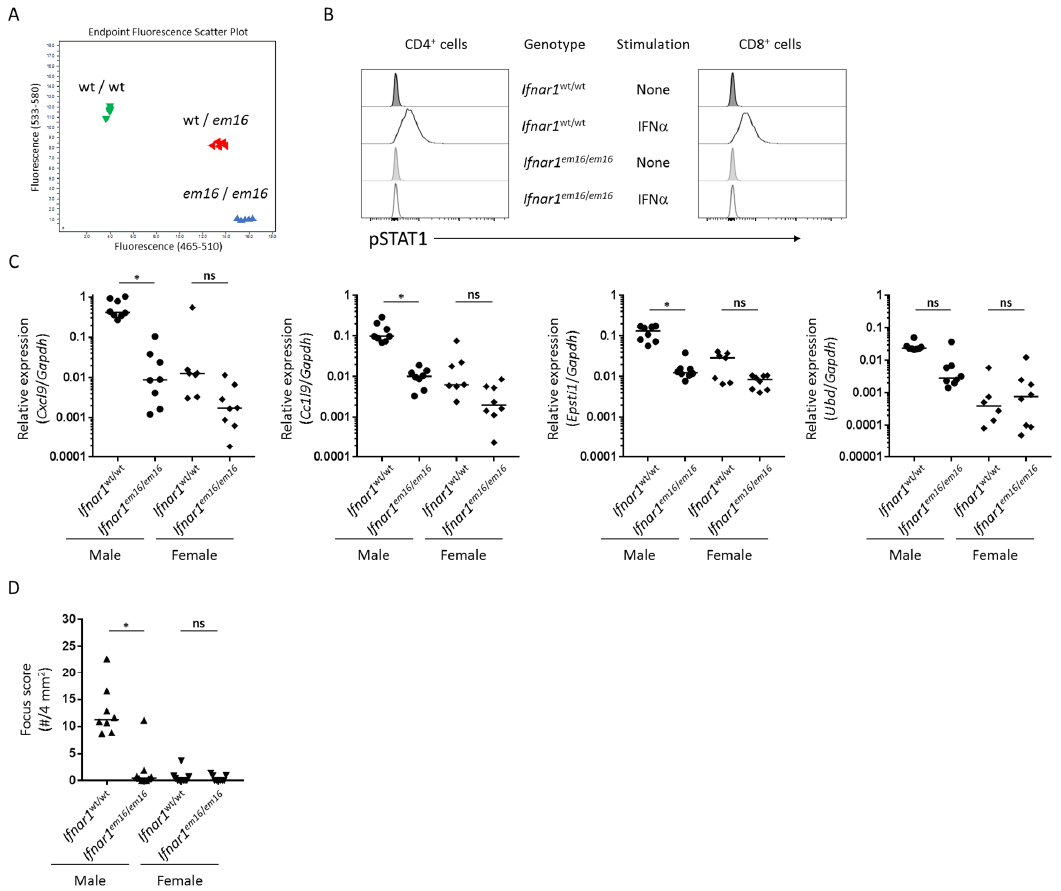
Figure 4. Type I IFN signaling is required for dacryoadenitis in male NOD mice. ( A ) Disruption of Ifnar1 in NOD mice was confirmed by genotyping with Taqman probe assay for the em16 mutant allele − 5 bp deletion. ( B ) Functional deficiency in IFNAR1 signaling was confirmed by flow cytometry. Whole blood from wild-type ( Ifnar1 wt/wt ) or Ifnar1 -deficient ( Ifnar1 em16 / em16 ) mice was stimulated with IFN α for 30 min then fixed and analyzed by flow cytometry for phosphorylation of STAT1 (pSTAT1). Histograms show pSTAT1 staining for CD4 + cells (left) or CD8 + cells (right). Cells not exposed to IFN stimulation were included as no stimulation controls. Similar levels of pSTAT1 staining was apparent from each group when stimulated with IFN γ as positive control (not shown). Data are representative of 2 mice per genotype. ( C ) Graphs depict gene expression of indicated genes normalized to that of Gapdh in lacrimal glands of 14–16 week old wild-type (Ifnar1 wt/wt ) or Ifnar1 -deficient ( Ifnar1 em16 / em16 ) male or female NOD mice as indicated on x-axis. Symbols represent individual mice, lines are medians. Relative expression ratios were log-transformed for statistical analysis. p < 0.001 for each gene data set by Kruskal-Wallis with p values for individual comparisons by Dunn multiple comparisons test as indicated for sex-matched wild-type versus Ifnar1 -deficient mice: * p < 0.05, ns p > 0.05. Individual mouse data points for wild-type males and females are also summarized in Table 2. ( D ) Graph depicts focus scores (as defined in Figure 1) as quantitation of dacryoadenitis in lacrimal glands of 14–16 week old wild-type ( Ifnar1 wt/wt ) or Ifnar1 -deficient ( Ifnar1 em16 / em16 ) male and female NOD mice. Symbols represent individual mice, lines are medians. p = 0.0003 by Kruskal-Wallis with individual comparisons by Dunn multiple comparisons test as indicated for sex-matched wild-type versus Ifnar1 -deficient mice: * p = 0.018, ns p >